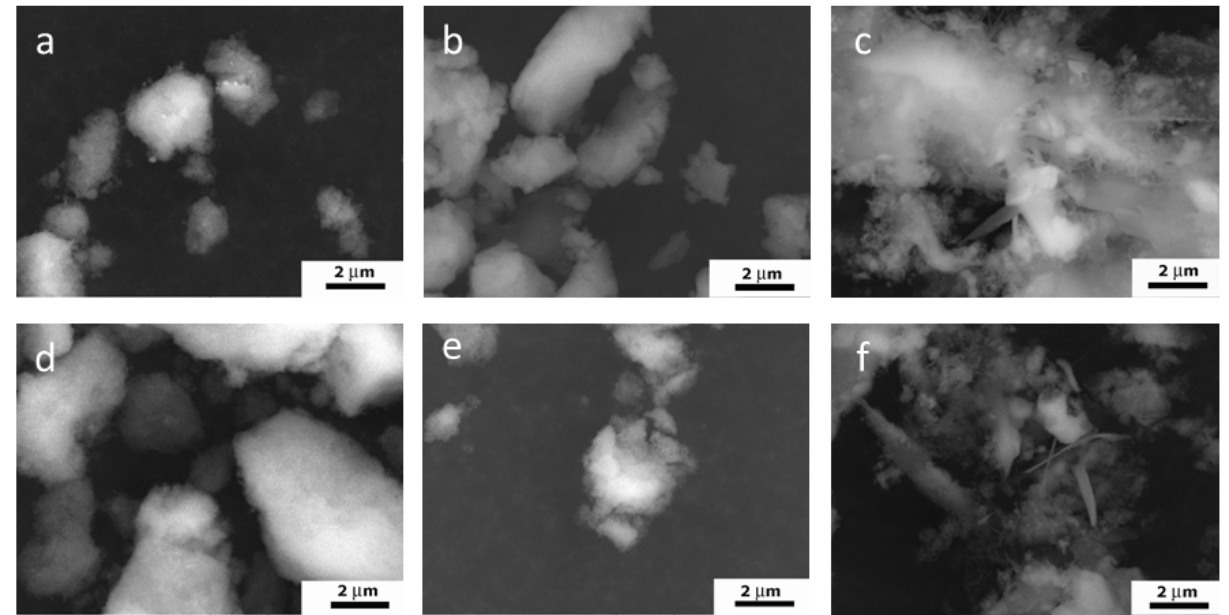
Figure 5. SEM images of HA powders synthesized in different media: W-1 ( a ), WA-1 ( b ), WE-1 ( c ), W-21 ( d ), WA-21 ( e ), WE-21 ( f ).